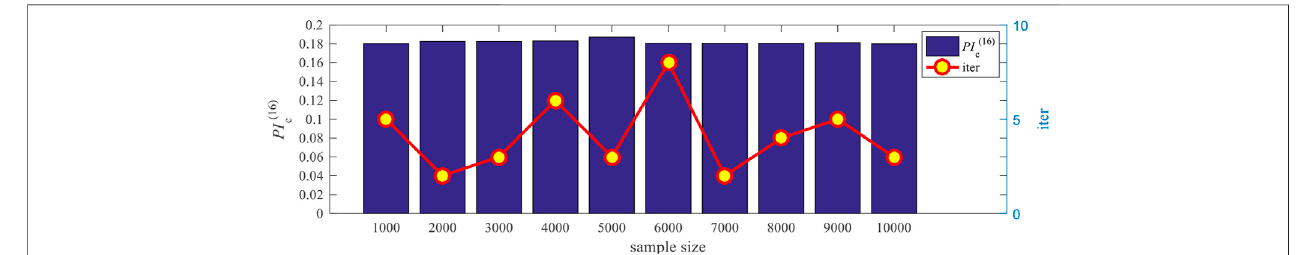
FIGURE 6 | PI c values of using CCOPF-L based on LHS with different sample sizes for contingency 16.